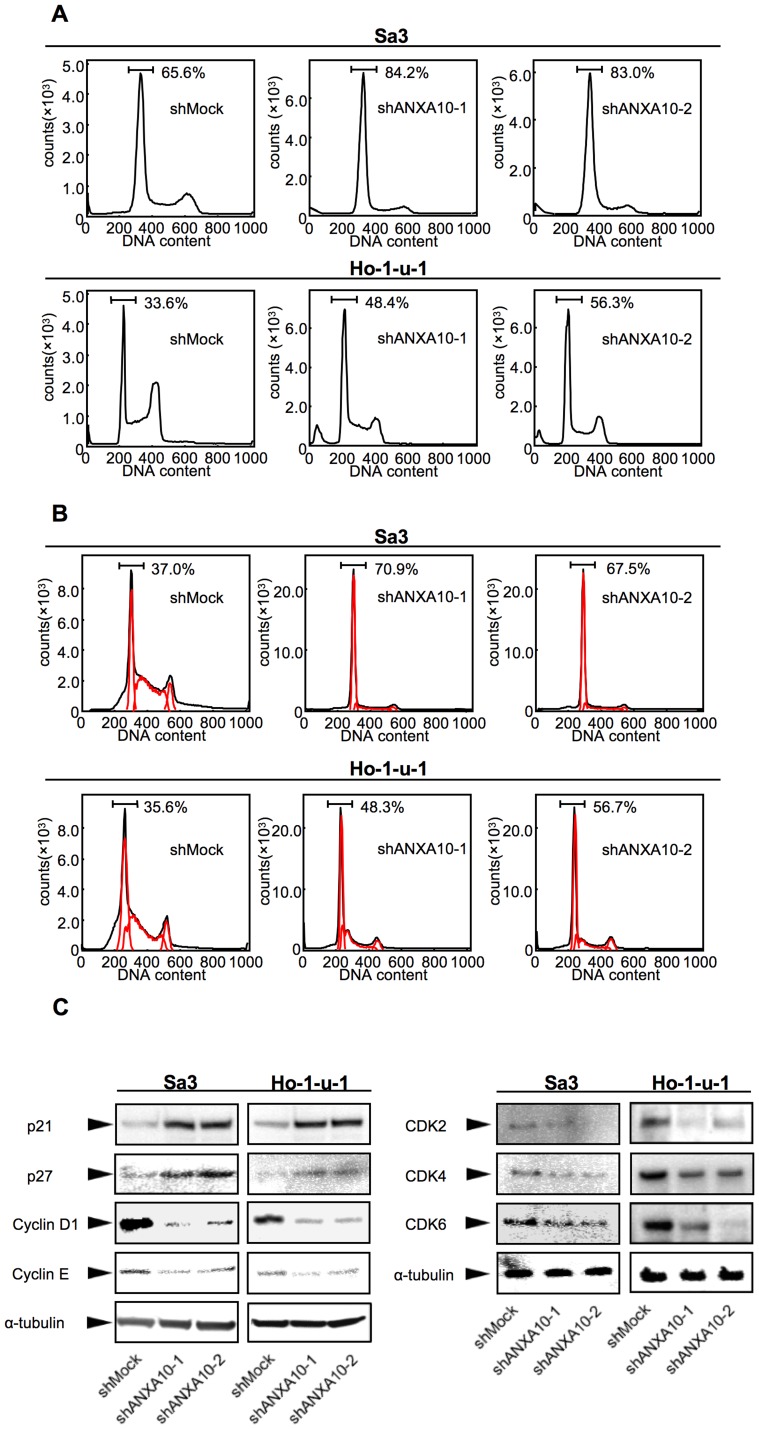
shANXA10 promotes G1 arrest.To investigate cell-cycle progression, we analyzed flow cytometric determination of DNA content by a FACScalibur in the G0–G1, S, and, G2–M phases. We determined the expression level of CDKIs (p21Cip1and p27Kip1), cyclin D1, cyclin E, CDK2, CDK4, and CDK6 to identify the mechanism by which ANXA10 inhibits cell-cycle progression in the G1 phase. (A) After synchronizing at G0/G1 phase with deprived of serum, flow cytometric analysis was performed to investigate the cell cycle in the shANXA10- and shMock-transfected cells. The percentage of the G1 phase in the shANXA10-transfected cells (Sa3- and Ho-1-u-1-derived transfectants; 2 clones each) has increased markedly compared with the mock-transfected cells (p<0.05, Mann-Whitney's U test). (B) After synchronizing at G2/M phase to treated with nocodazol, flow cytometric analysis was performed to investigate the cell cycle in the shANXA10- and shMock-transfected cells. The percentage of the G1 phase in the shANXA10-transfected cells (Sa3- and Ho-1-u-1-derived transfectants; 2 clones each) has also increased markedly compared with the mock-transfected cells (p<0.05, Mann-Whitney's U test). (C) Immunoblotting analysis shows up-regulation of p21Cip1and p27Kip1 and down-regulation of cyclin D1, cyclin E, CDK2, CDK4, and CDK6 in the shANXA10-transfected cells (Sa3- and Ho-1-u-1-derived transfectants; 2 clones each) compared with the shMock-transfected cells.